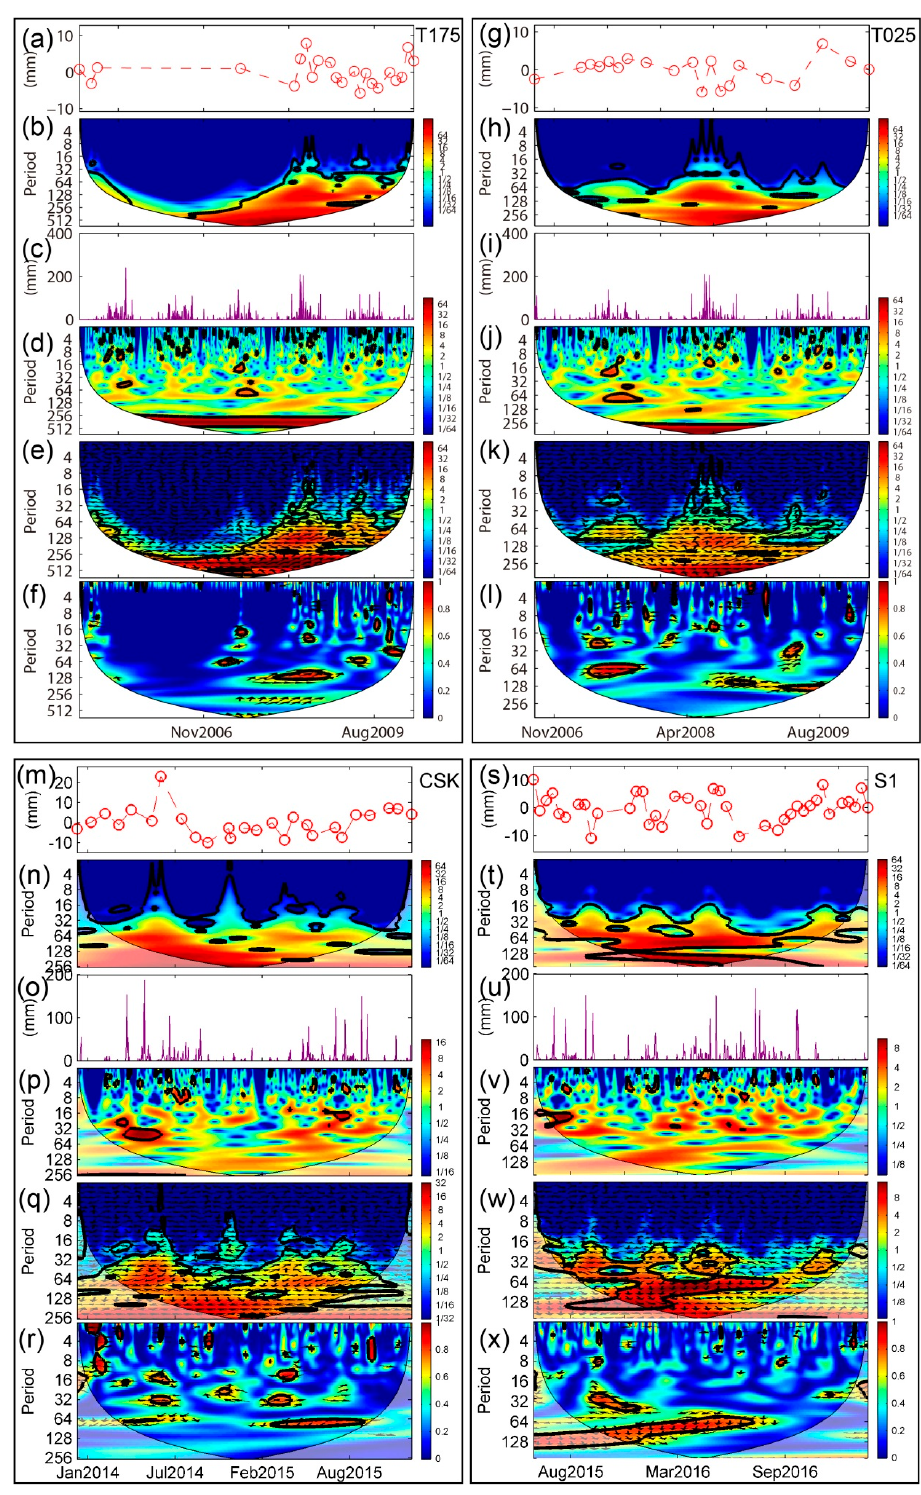
Figure 15. ( a ) Detrend of Envisat T175 time series at Point P1 (Figure 5b); ( b ) Continuous wavelet power of the Envisat T175 time series; ( c ) Daily precipitation recorded by China Meteorological Administration, specifically meteorology station No. 59493 in Shenzhen [51]; ( d ) Continuous wavelet power of precipitation time series; ( e ) Cross wavelet transform of Envisat T175 and precipitation time series at P1; ( f ) Wavelet coherence of Envisat T175 and precipitation time series at P1; ( g – l ) Are the same for Envisat T025 and precipitation time series at P1; ( m – r ) Are the same for CSK and precipitation time series at P1; ( s – x ) Are the same for S1 and precipitation time series at P1. The thick contour is the 95% confidence level. The cone of influence (COI) is shown in light shadow.